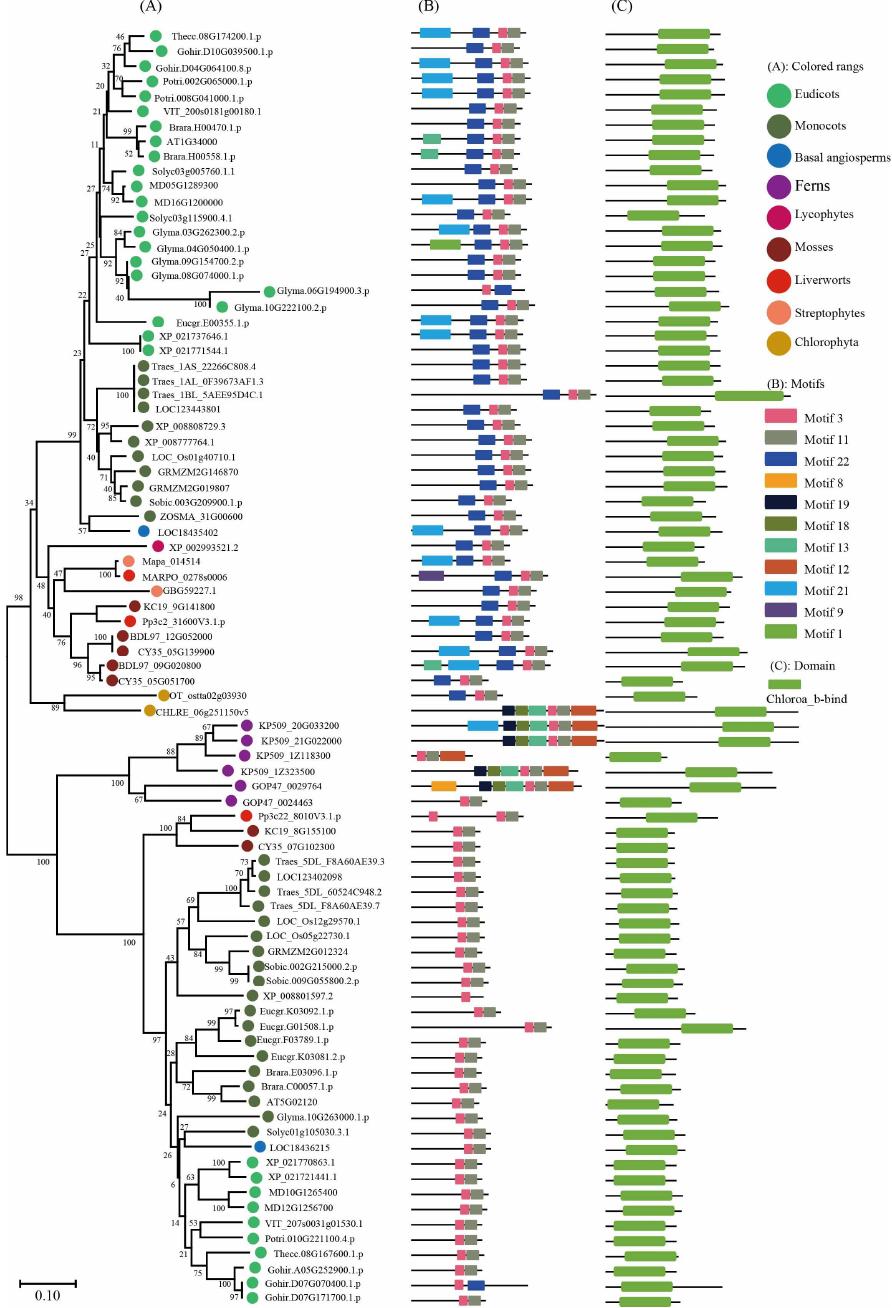
Figure 3. Phylogenetic evolutionary tree, protein motifs, and domains of the OHP subfamily members: ( A ) Unrooted phylogenetic tree of the OHP subfamily; ( B ) motifs of the OHP proteins. The different colors indicate 11 motifs (left panel); and ( C ) protein domains of the OHP genes.